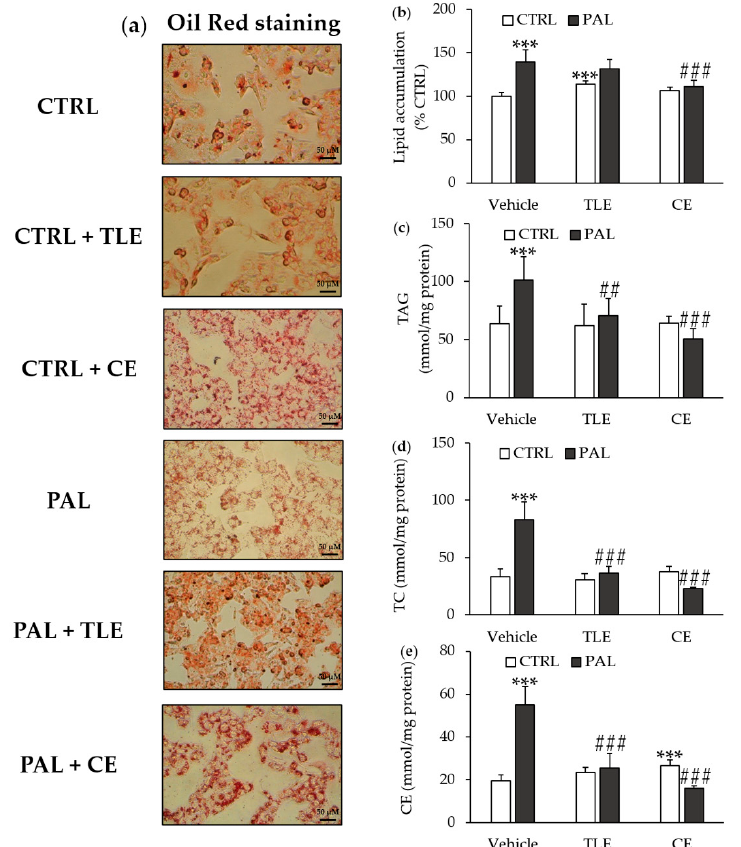
Figure 2. Effect of total lipophilic and carotenoid extracts from P. tricornutum on non-alcoholic fatty liver disease (NAFLD). The HepG2 cells were treated with the control vehicle (CTRL, 1.16% ethanol) alone or associated with total lipophilic extract (CTRL + TLE, 100 µg/mL) or carotenoid extract (CTRL + CE, 6 µg/mL) for 24 h. In parallel, the HepG2 cells were exposed to palmitate vehicle (PAL, 250 µM) alone or associated with the TLE (PAL + TLE) or the CE (PAL + CE) for 24 h. ( a ) Lipid droplets were detected by Oil Red staining, original magnification × 400; ( b ) Lipid accumulation was quantified by the solubilization of lipid droplets stained in Oil Red with isopropanol; ( c ) Intracellular triglyceride (TAG) values; ( d ) Intracellular total cholesterol (TC) values; ( e ) Intracellular cholesterol ester (CE) values. Data are the means ± standard deviations from at least three independent experiments. Statistical significance was determined using ANOVA with post-hoc Fisher‘s test, and asterisks indicate significant differences compared to the CTRL vehicle with *** p < 0.001. Hashtags indicate significant differences compared to the PAL vehicle with ## p < 0.01 or ### p < 0.001.